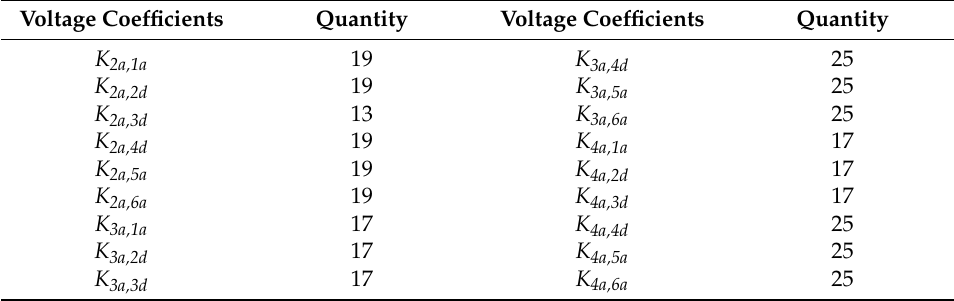
Table 2. The number of voltage